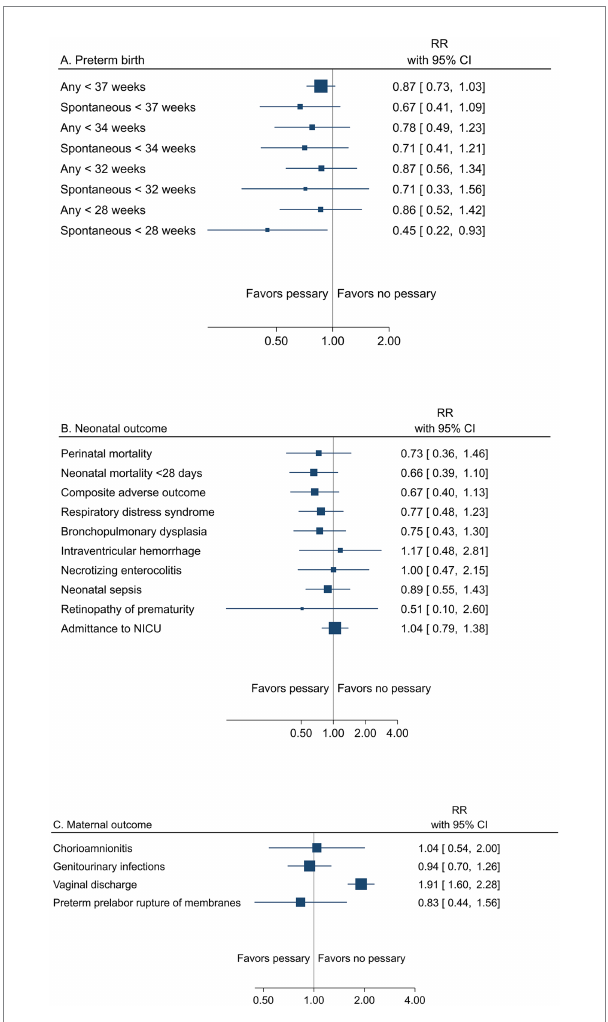
FIGURE 4 Summary graph of pooled estimates from meta-analyses comparing pessary versus pessary in women with a singleton pregnancy and short cervical length, from trials with low risk of bias regarding (A) preterm birth, (B) neonatal, and (C) maternal